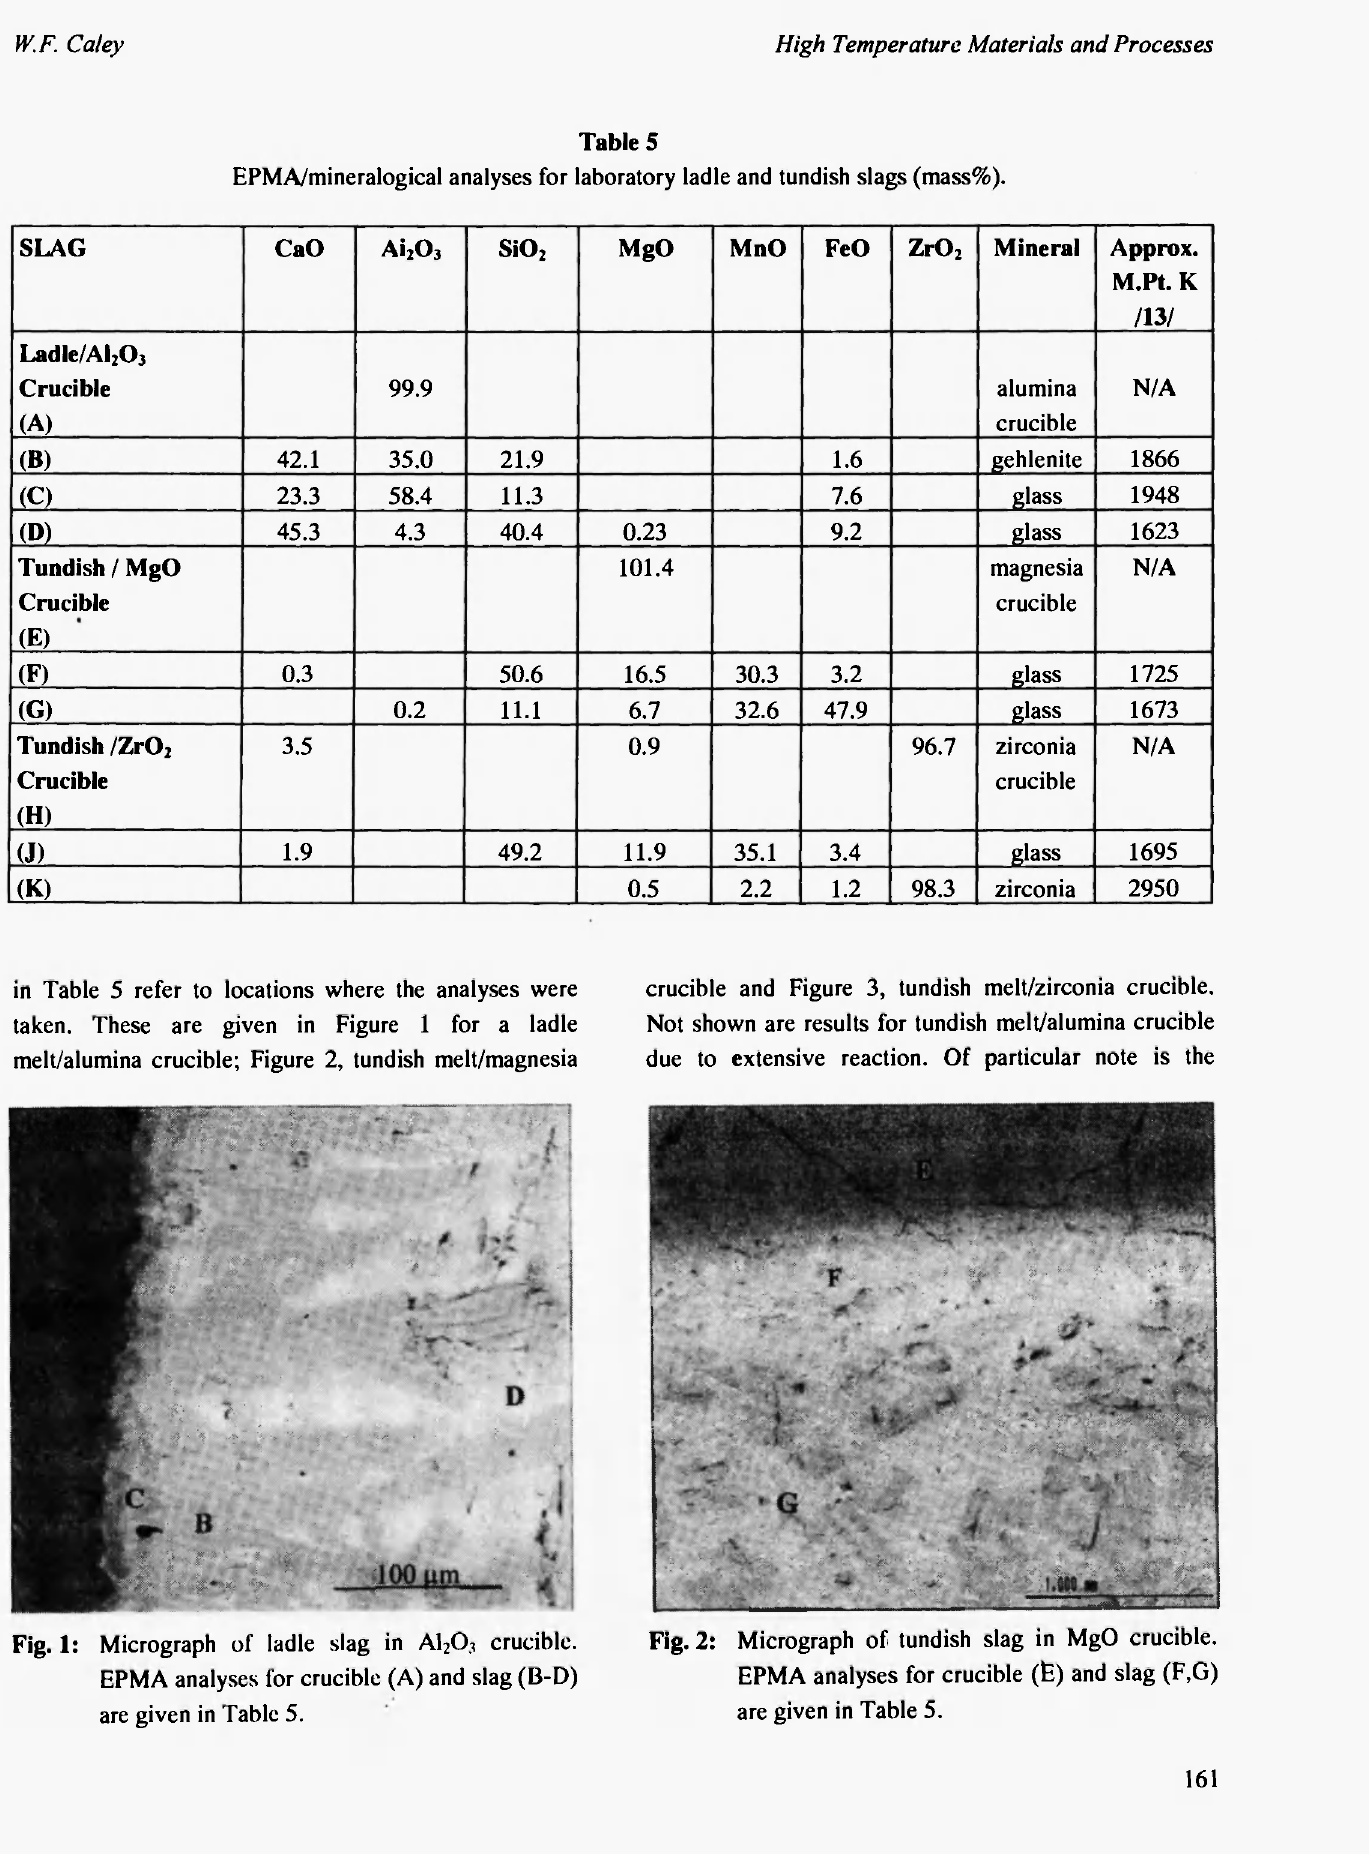
Fig. 1: Micrograph of ladle slag in A1 2 0 3 cruciblc. ΕΡΜΑ analyses for crucible (A) and slag (B-D) are given in Table 5.